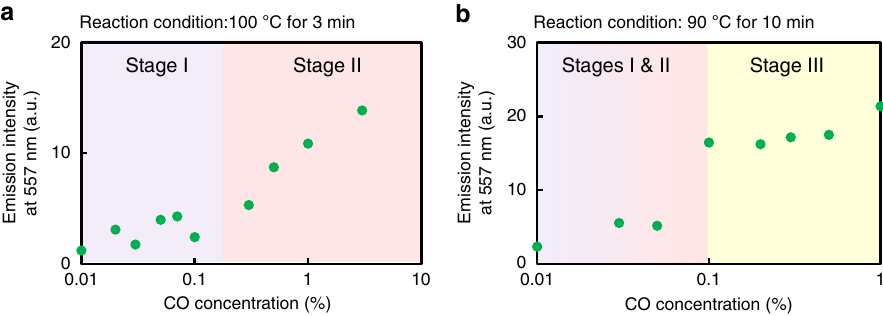
Fig. 6 Tunable thresholds in dual self-controlling system. Concentration dependence of the emission intensities at 557 nm (deoxygenated condition, excitation at 365 nm) after reactions with various concentrations of CO gas; a at 100 °C for 3 min and b at 90 °C for 10